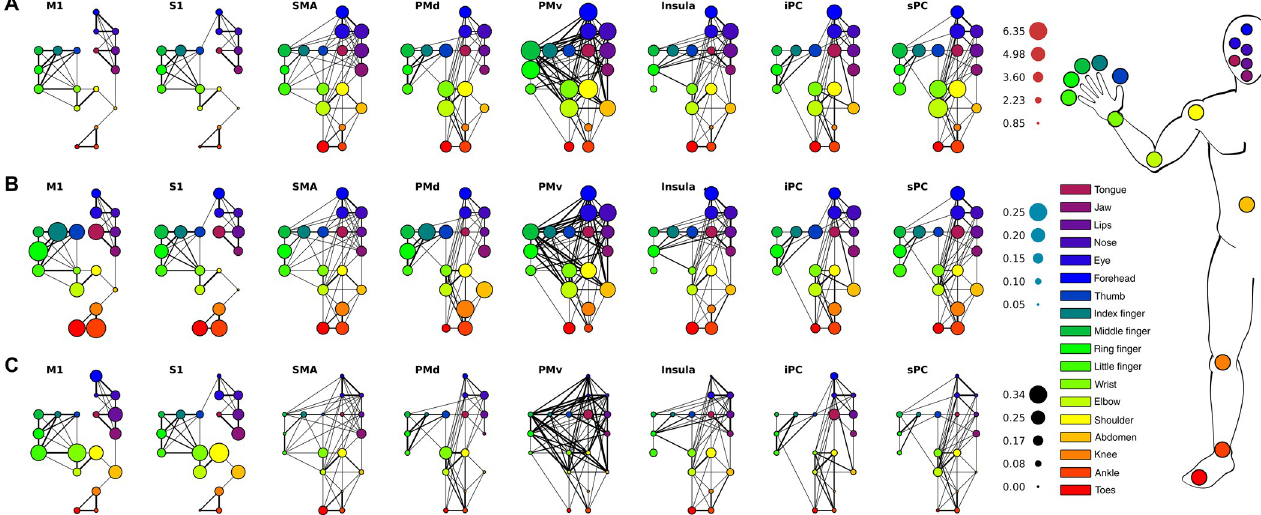
Fig 7. Graph theory results. Whole-body-graphs are presented per ROI (from left to right) and for the connectivity, clustering and betweenness centrality coefficients (from top to bottom). The colors of each node in the graphs correspond to a specific body part given by the schematic at the far right. The connections between any 2 body part nodes was calculated per ROI and shown here through the lines connecting the nodes. The thicker the line the stronger the connection between body parts. (A) Connectivity values per body part node and ROI are depicted. The size of the body part nodes presents the size of the connectivity value per node. (B) Clustering coefficients have the same layout and graphs as the connectivity values. Here the size of the body part node reflects the strength of the clustering coefficient. (C) The size of the body part nodes in the ROI graphs reflects the strength of the betweenness centrality coefficient.